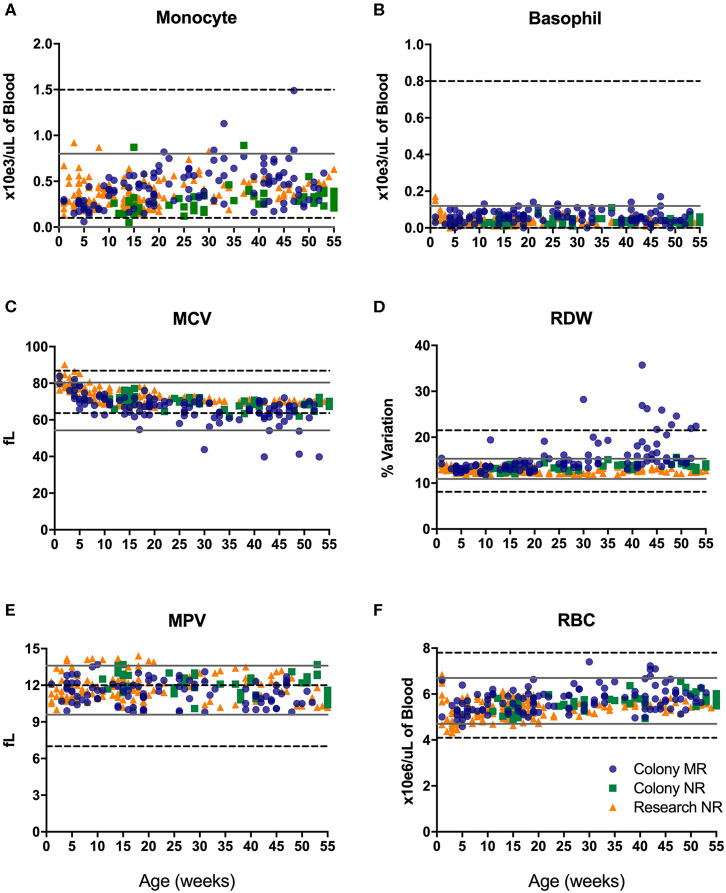
Reference ranges of selected CBC results from pediatric infant animals (gray solid lines plotted as +/– 2 std. dev. of the mean) illustrate differences from established adult rhesus macaque reference ranges (dotted black lines). Individual data points were from animals in the Colony MR (blue circles), Colony NR (green squares), and Research NR (orange triangles) groups comparing; monocyte number (A), basophil number (B), mean corpuscular volume or MCV (C), red cell distribution width or RDW (D), mean platelet volume or MPV (E), and red blood cell count or RBC (F).